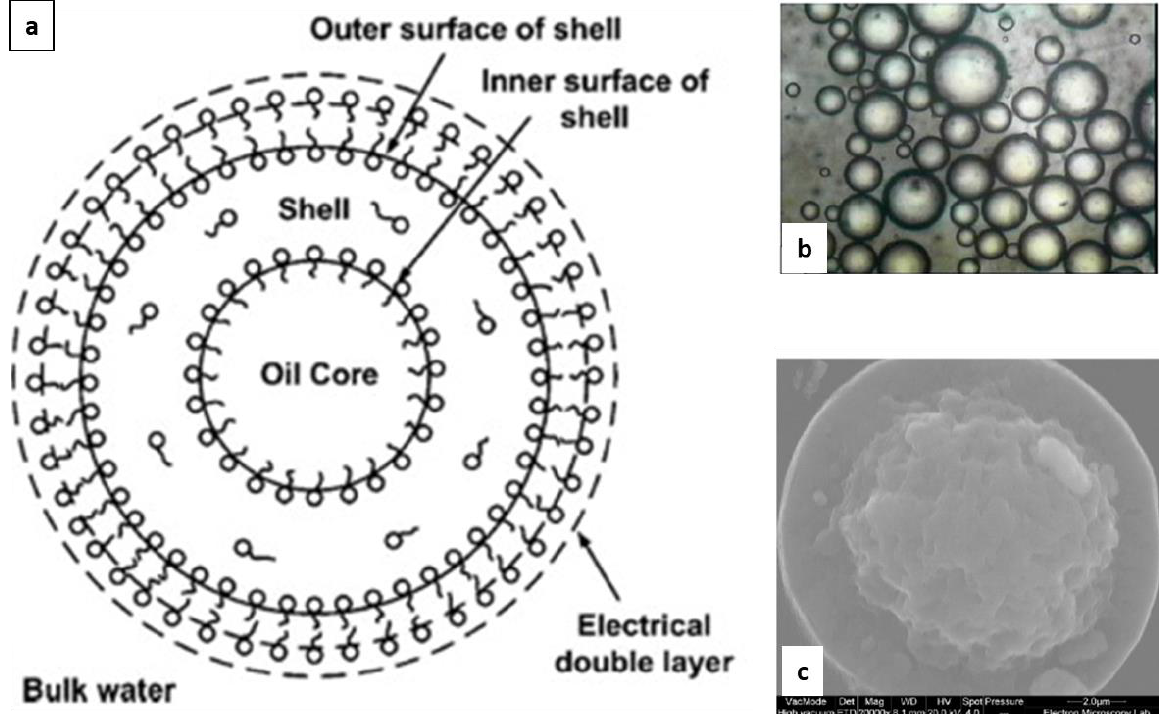
Figure 1. An aphron consists of a core of apolar solvent encapsulated in an outer shell with a multi- layer structure of oil, water, or water-soluble surfactant which stabilizes the core in the continuous phase (panel ( a )). The multimolecular layer forms a robust shell around oil droplets, improving the colloidal stability of aphrons (panel ( b ), adapted from [29]). The size of the polyaphron droplet is comprised in the micron range. The cryo-SE microphotograph of a fractured aphron shows also the presence of a central, rough region surrounded by a smooth outer shell (panel ( c ), adapted from [30]). Nowadays, the multi-layer organization is described as a dynamic nanoscale 3D bicontinuous structure involving not only the surfactant, but also bond water and oil [31]. In a Cal/BD fixed-dose combination product, the cream comprises two sets of aphrons, in which either BD or Cal are separately encapsulated, in an aqueous continuous phase consisting of a carbomer hydrogel at pH around 7.75. According to the compositions described in the patent, the cream can contain from 70% to 90% of the dispersed oil phase and as little as 0.5% (reaching a maximum of 3%) of surfactant/polymer of the total weight [32,33]. Indeed, the distribution of surfactants in aphrons allows the stabilization of the inner oil core; and at the same time, the total amount required to avoid creaming is from several fold up to 30-fold lower than in conventional creams and lotions with a comparable content of oil. This peculiar feature allows avoiding the wash-off of epidermal lipids which leads to the disruption of the skin barrier properties and irritation [34]. Moreover, the lower the surfactant levels, the lower the solubility of lipophilic drugs, such as Cal and BD, in the aqueous phase; in other words, the overall chemical stability of active ingredients is improved over the storage period [31]. The cream composition is also responsible for the greater skin flux compared to the marketed Cal/BD oleogel and ointment (Table